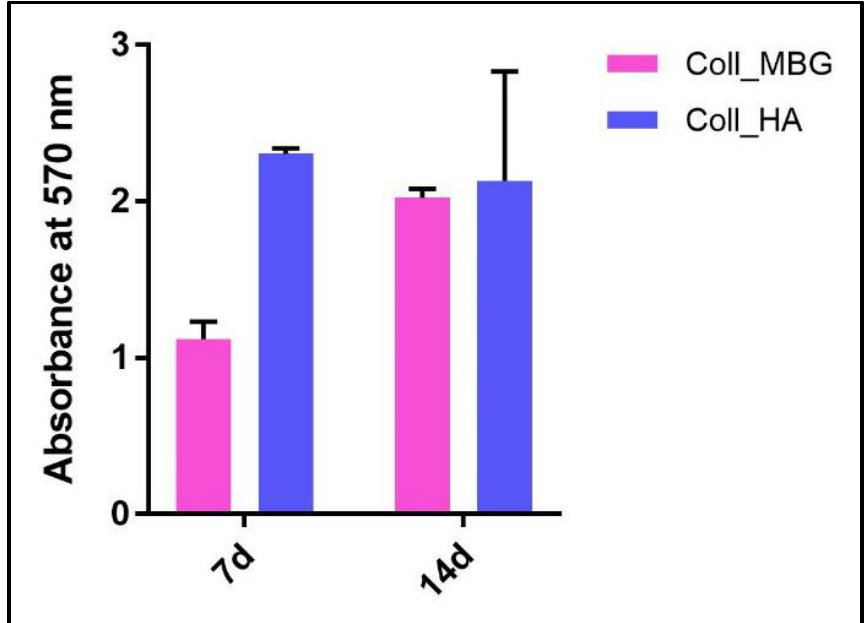
Figure 15. Alizarin Red eluate quantification after staining of osteoblasts seeded on the collagen-based scaffolds with nano-hydroxyapatite (Coll_HA) and collagen-based scaffolds containing mesoporous bioactive glasses